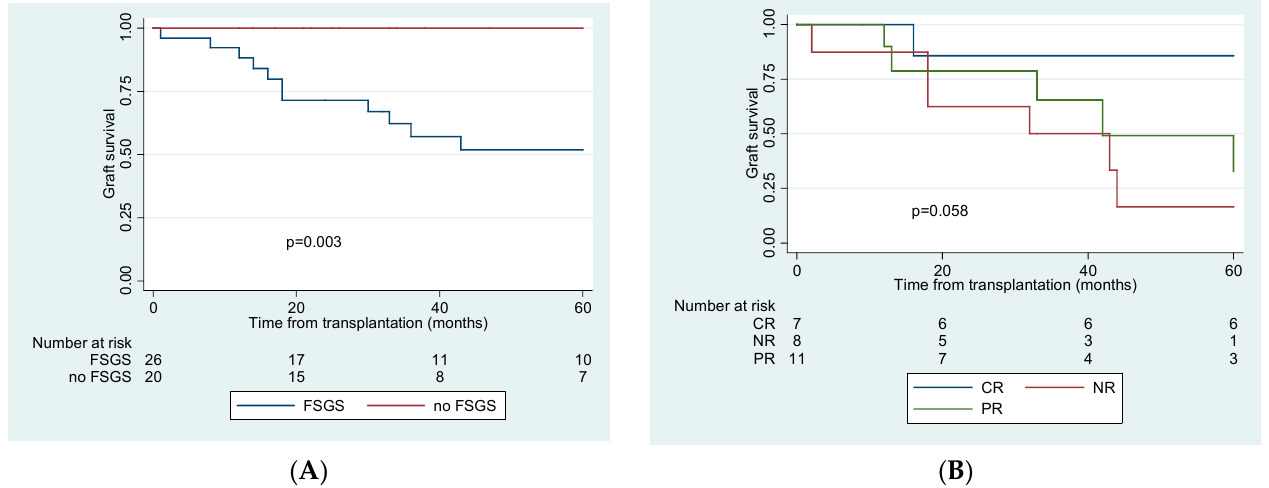
Figure 2. Kaplan–Meier 5-year graft survival curve comparing ( A ). patients with and without recurrence of FSGS post- transplantation and ( B ). patients with complete, partial and no response to treatment of recurrence. CR: complete remis-